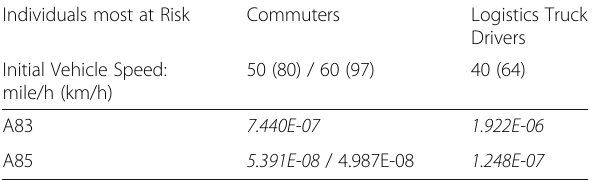
Table 2 Combined PIR for Scenarios A and B for individuals most at risk: commuters and logistics truck drivers (PIR at the speed limit italicised) Individuals most at Risk